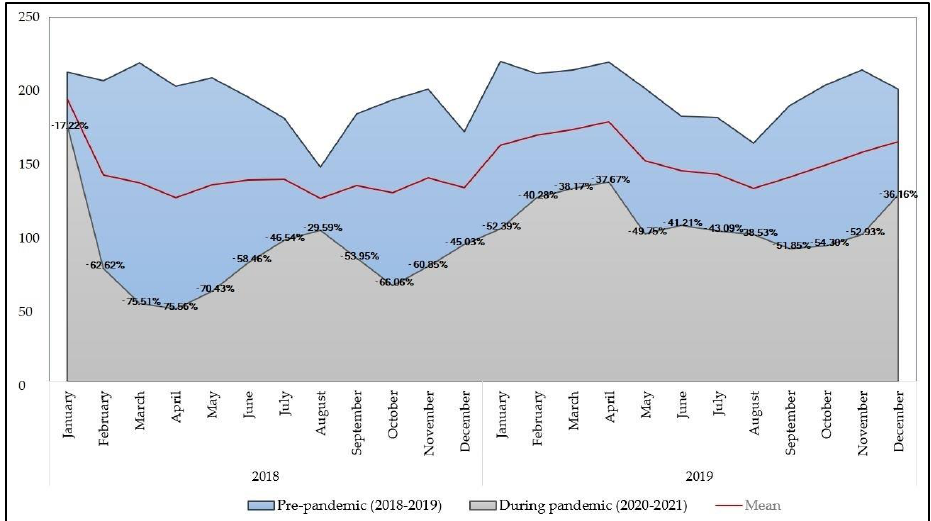
Figure 1. Evolution of cervical cancer screening before and during the COVID-19